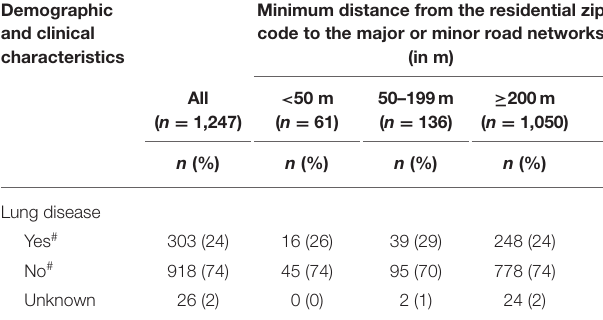
TABLE 1 | Demographic and clinical characteristics of the myositis study cohort ( n =